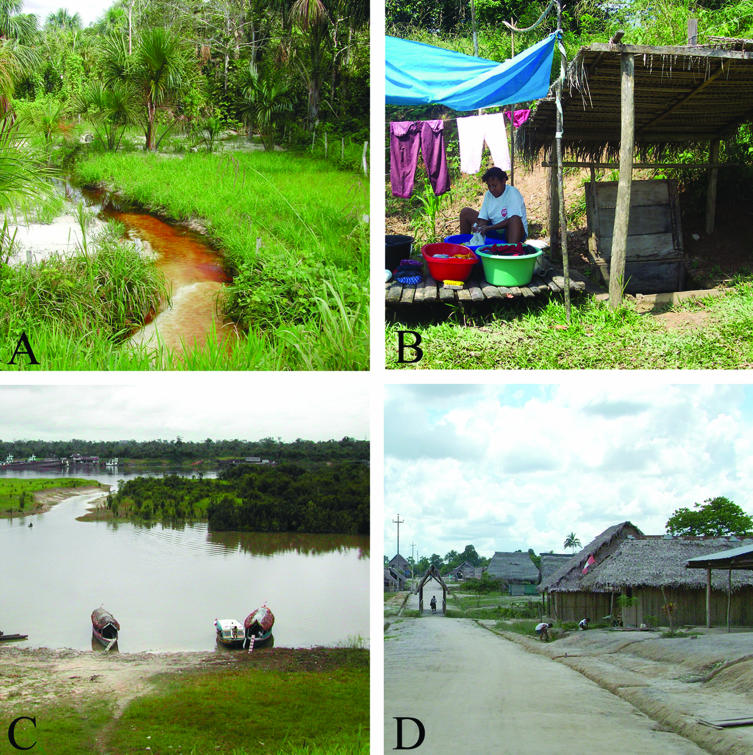
The Rural Village of Padrecocha, Outside of Iquitos(A) A quebrada (stream), strongly associated with leptospirosis transmission.(B) A typical well in close association with activities of daily living.(C) The pond of Padrecocha (the cocha) adjacent to the river.(D) Flooding in the village during the high river season after heavy rains.(With kind permission of Springer Science and Business Media)